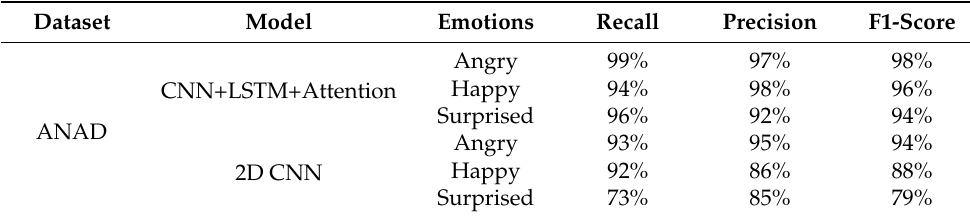
Table 2. Individual class performance evaluation metrics—ANAD.